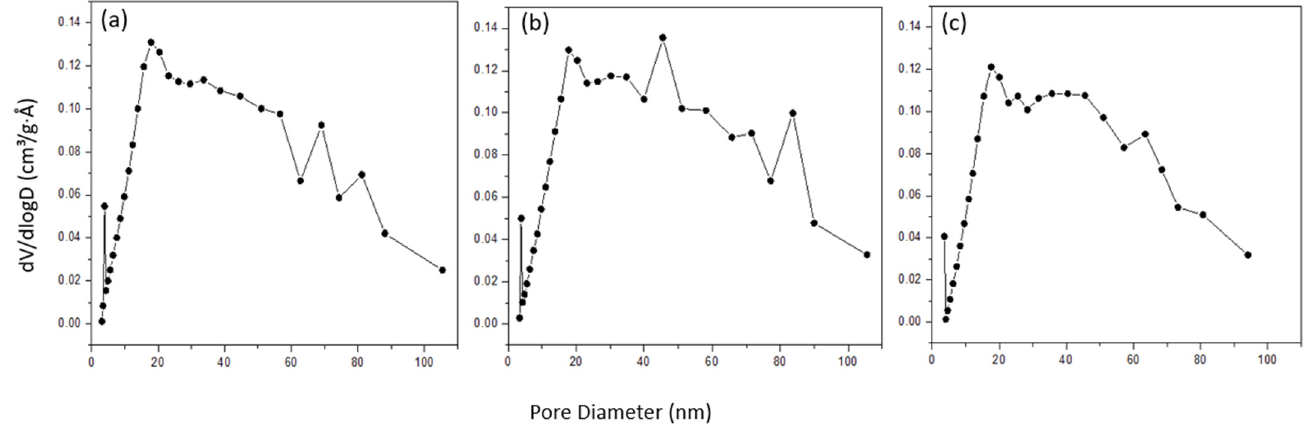
Figure 6. The pore size distribution of ( a ) NZ, ( b ) PZ, and ( c ) SZ.